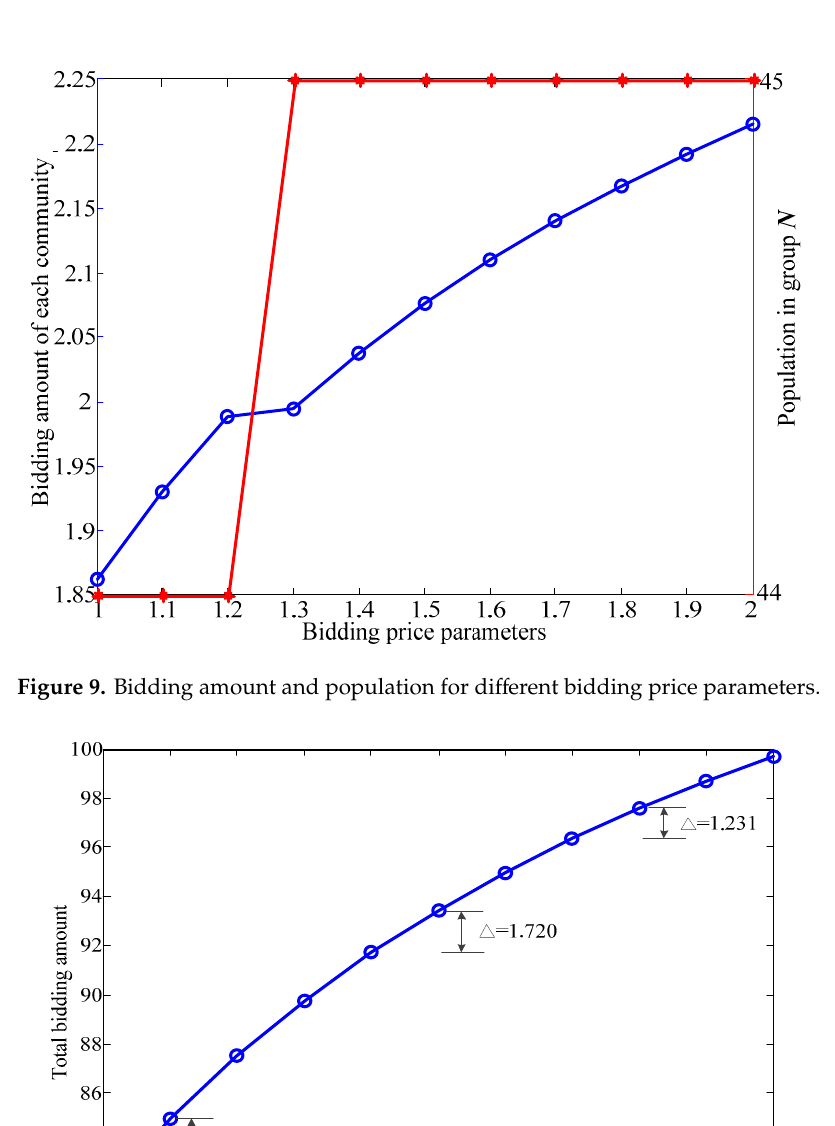
ff erent bidding price